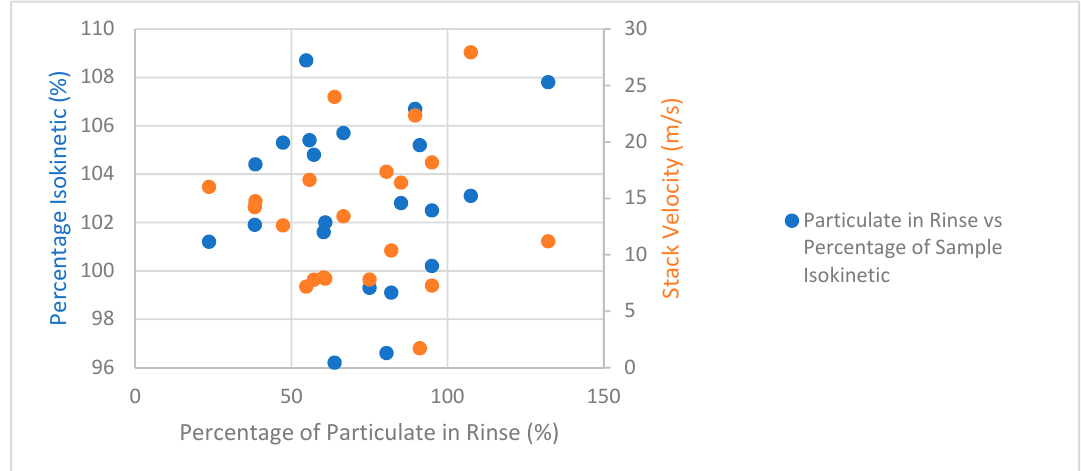
Figure 4. Isokinetic percentage of each process detailing the percentage of particulate in the rinse.